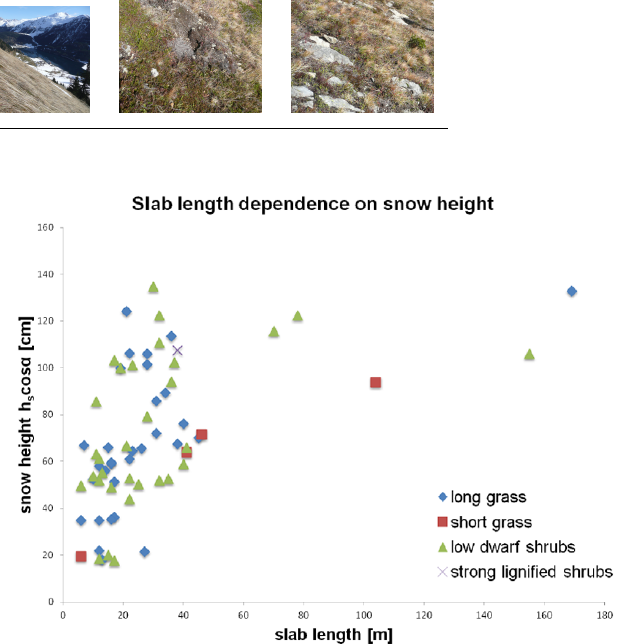
Figure 8. Slab length and snow height correlate weakly (Pearson coefficient of correlation squared: R 2 = 0 . 25). The longest slabs l g were observed for snow heights h s cos α greater than 90cm. Whereas short release areas (up to 50m) are possible for any snow height, long slabs are characteristic of large snow heights. Here, we only look at the 67 events where we assume a stauchwall to be